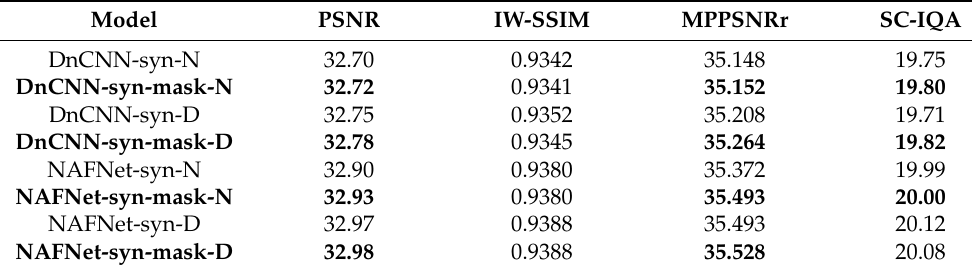
Table 9. SVQE comparison among DnCNN- and NAFNet-based schemes ( model-syn-N/D ) and that with DIBR distortion prediction ( model-syn-mask-N/D ) on Seqs-H.264. Only when the SVQE models with DIBR distortion prediction (highlighted bold) are superior than the same model pre-trained on the same synthetic database, the results are highlighted